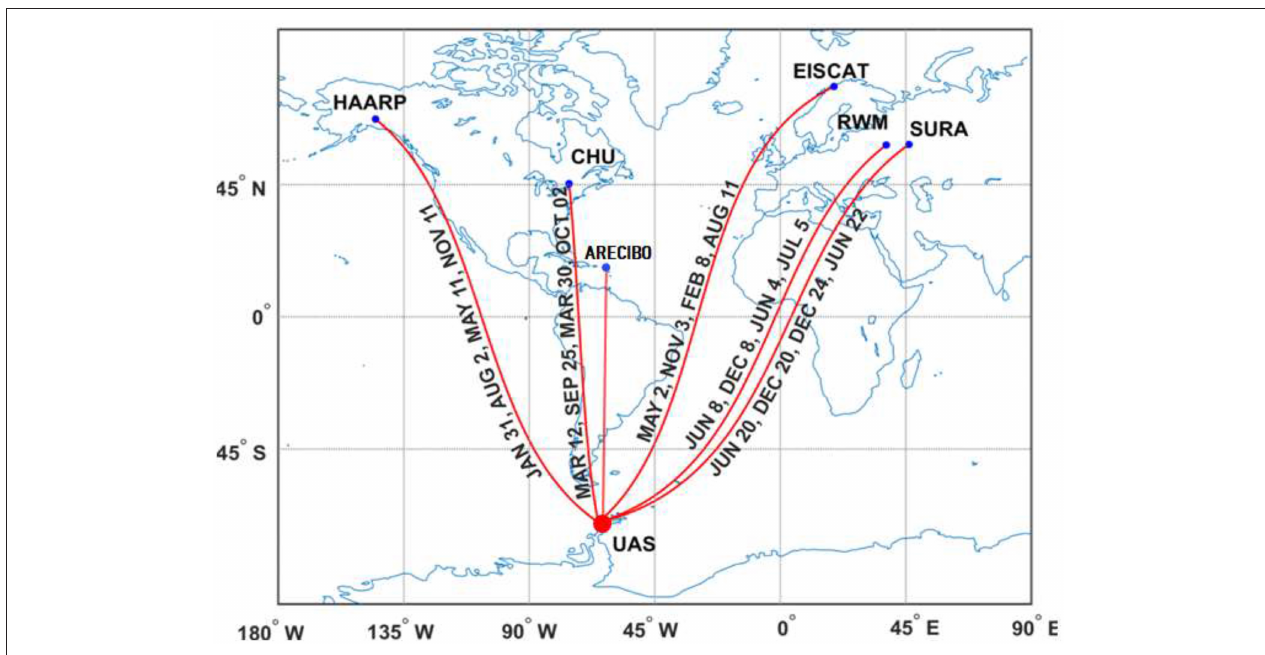
FIGURE 1 | Map of the solar terminator lines and super-long range radio